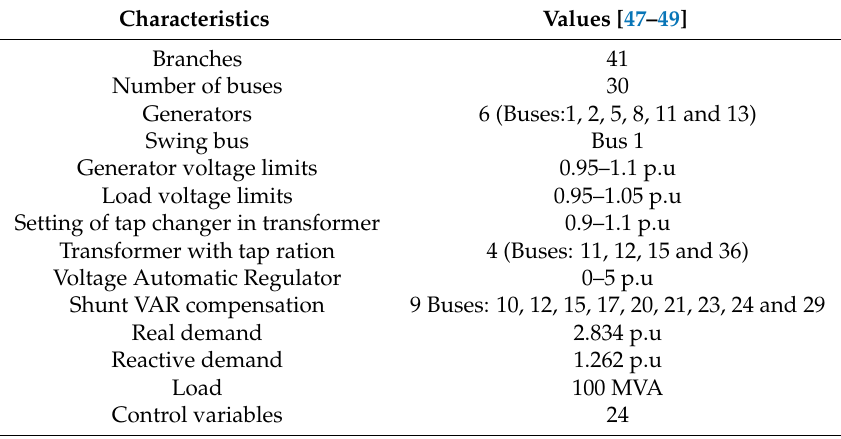
Table 3. The general specifications of the IEEE 30-bus